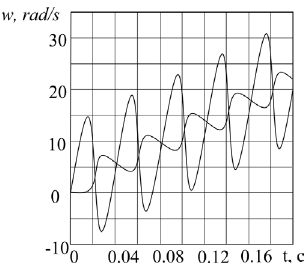
Fig. 8. The angular velocities of the first and second masses with the gaps of the mechanical transmission